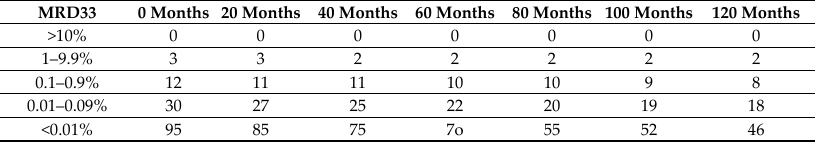
RFS-relapse-free survival, MRD33-minimal residual disease on day 33, EOI-end of induction. Cen- sored events are marked with a tick through the line. Cancers 2022 , 14 , x FOR PEER REVIEW 11 of 21 Figure 1. Relapse free survival of patients with respect to MRD33 (EOI), p < 0.01.